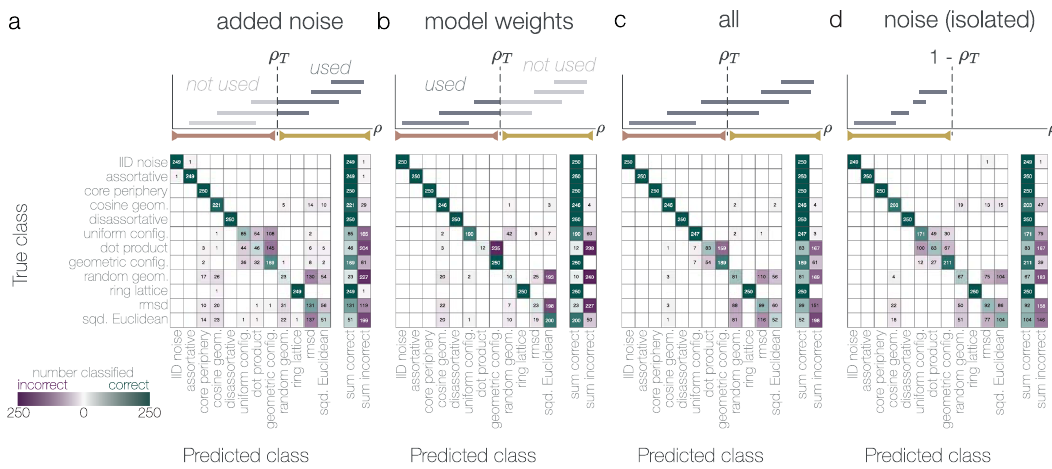
Fig. 4 Classi fi cation based on the added noise persistent homology can distinguish between network models. Confusion matrices showing the results of the classi fi cations based on a added noise barcodes, b the barcode from model weights only, c the entire barcode, and d barcodes generated from the isolated added noise networks. Example barcodes above confusion matrices describe the portion of the barcode used for that classi fi cation experiment, and any portion not used. Matrix entries show the number of corresponding true models that were classi fi ed as the corresponding predicted model, out of 250 (see “ Methods ” section). ρ indicates edge density and ρ T indicates threshold edge